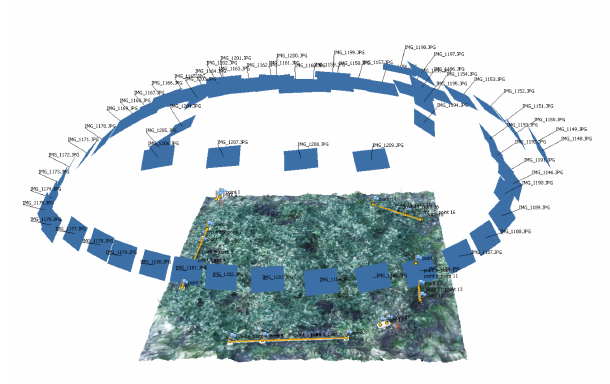
Figure 3. Camera configuration to generate a 3D representation of Onobrychis viciifolia using SfM and dense matching.